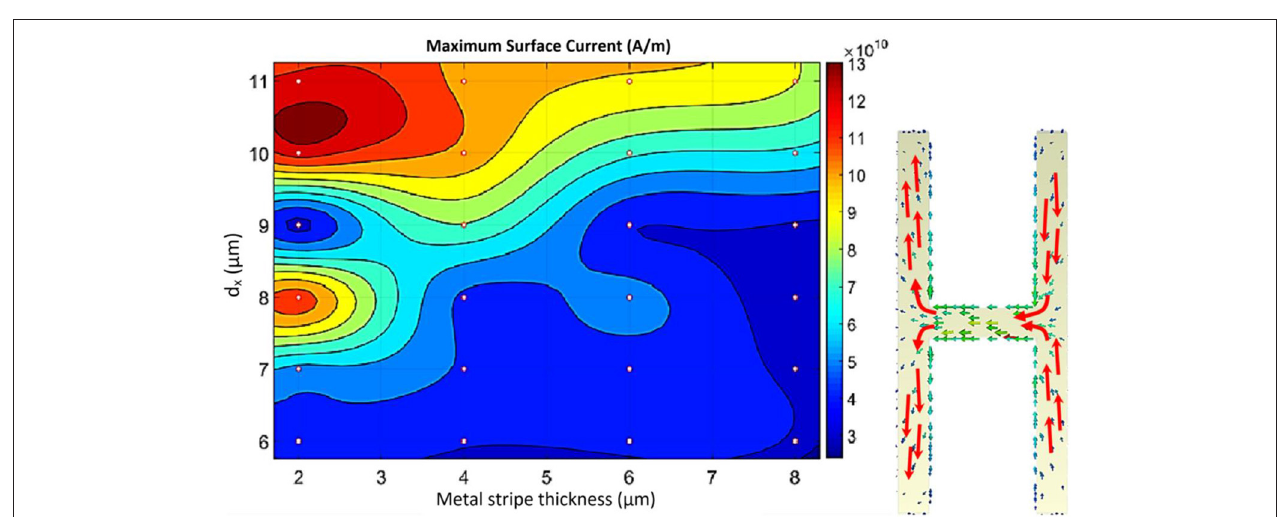
FIGURE 6 | Maximum surface current of the structure. In a similar way, a higher surface current can cause a sharper resonance dip. Consequently, investigating the best possible physical dimensions can increase the sensing capabilities. Similar to what has been done for the maximum electric field, 24 simulated data points are used for the estimation of all possible combinations. Thus, a biharmonic function is considered as a fitting tool to estimate the surface current for all combinations. As can be predicted, the same dimension values are obtained for the maximum surface current as have been calculated for the electric field.